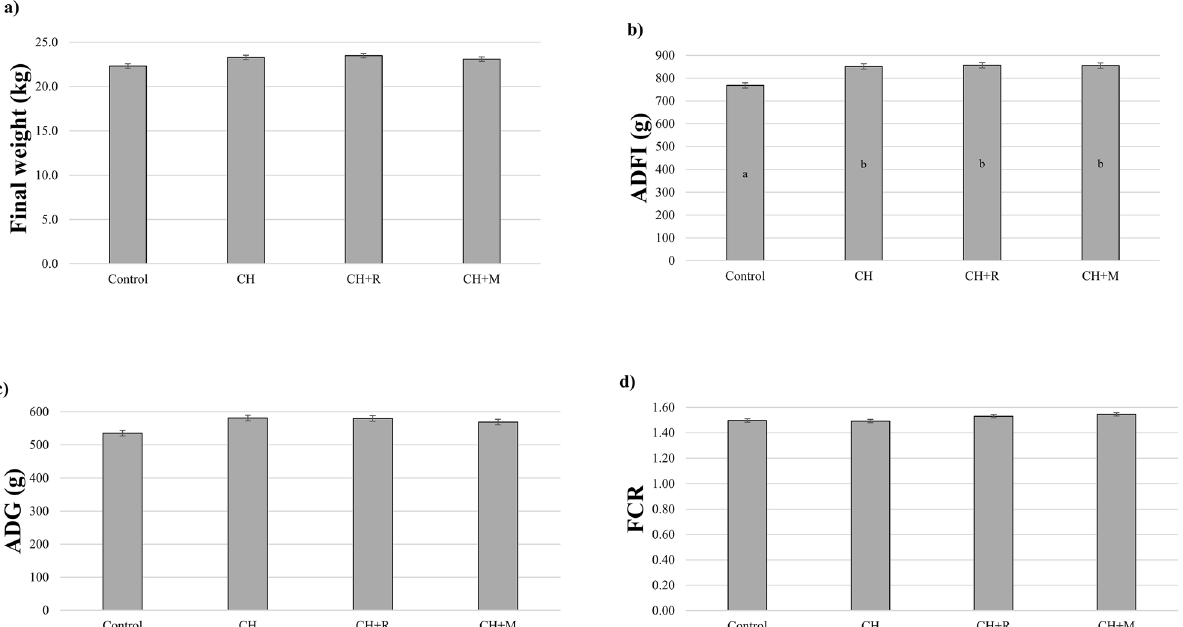
Figure 1. Influence of experimental diets on growth performance variables of piglets. ( a ) final body weight (kg), ( b ) ADFI—average daily feed intake (g), ( c ) ADG—average daily gain (g) and ( d ) feed conversion ratio. Dietary treatments: Control—control diet; CH—5% Chlorella vulgaris diet; CH+R—5% Chlorella vulgaris diet supplemented with 0.005% Rovabio Excel AP; CH+M—5% Chlorella vulgaris diet supplemented with 0.01% enzymatic mixture. a,b Values with different superscripts differ significantly at p ≤